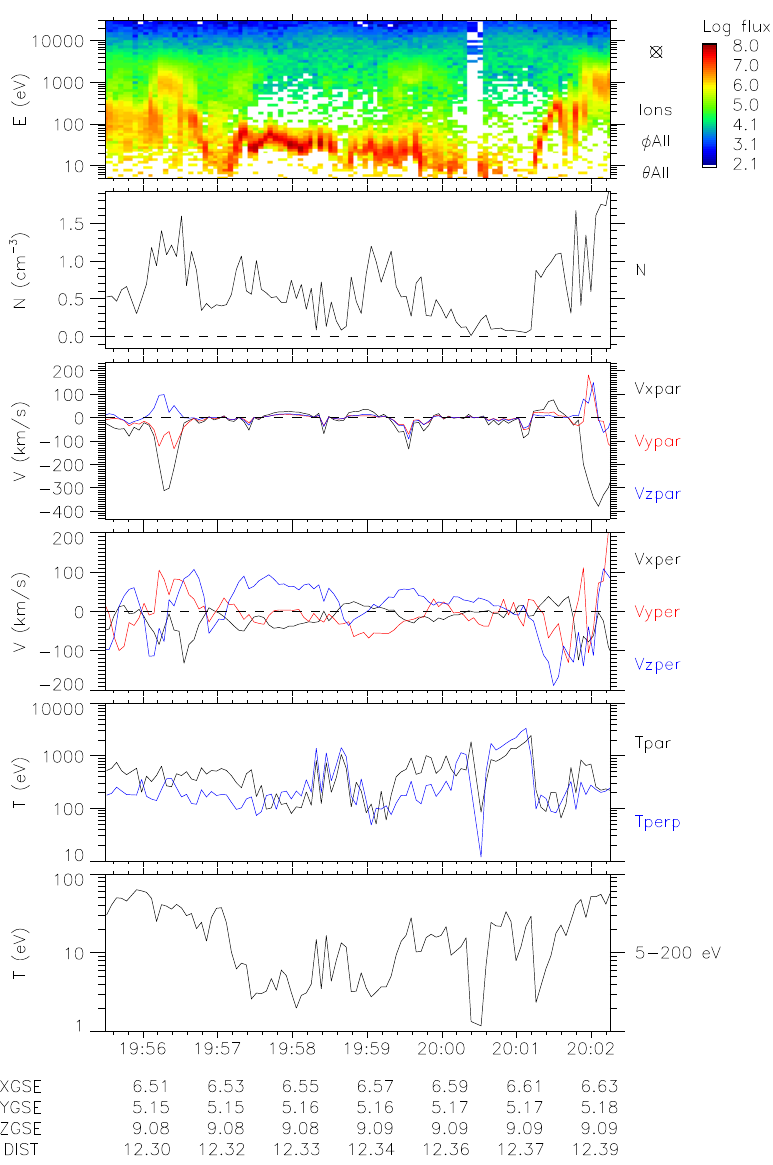
Fig. 8. Same as Fig. 6 for an event oc- curring on 16 February 2001 except that the density variation has been added to this figure (panel